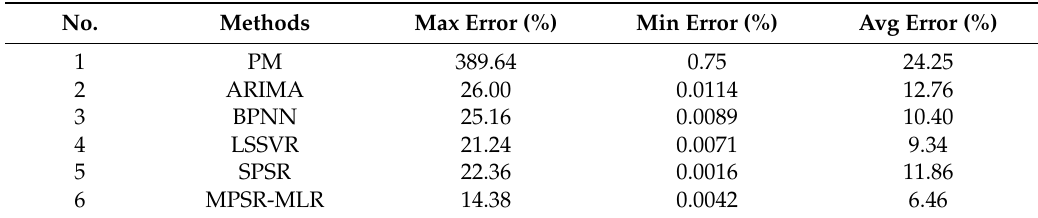
Table 4. Historical data of a wind